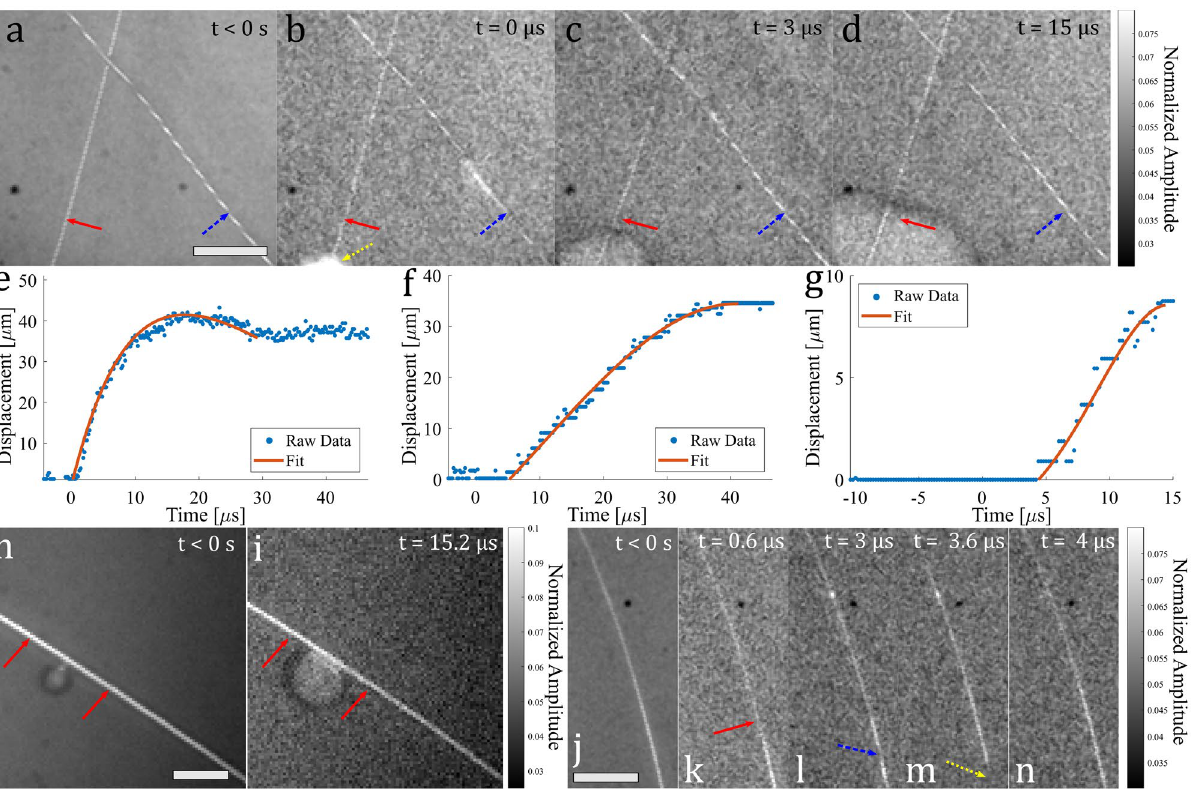
Figure 4. ( b )–( d ) Motion in crossed 25 µ m diameter gold wires submerged in a thin layer of distilled water and covered with a coverslip following laser-induced bubble generation, with ( a ) showing the mean of pre-excitation frames, scale bar: 200 µ m. In ( a )–( d ) Solid red and dashed blue arrows indicate the initial position of the left and right wires, respectively. ( e ), ( f ) Wire displacement against time for both left and right wires in ( a )–( d ), respectively. ( h ) mean of pre-excitation frames for a 25 µ m diameter gold wire touching a pre-existing bubble and ( i ) motion following pulse excitation, with red solid arrows indicating initial positions, scale bar: 100 µ m. ( g ) Wire displacement against time for ( h ), ( i ). ( j ) Mean of pre-excitation frames for a 25 µ m diameter gold wire submerged in a layer of intralipid scattering media, with the top being more submerged than the bottom; ( k )– ( n ) motion following pulse excitation with arrows indicating regions on interest, scale bar: 200 µ